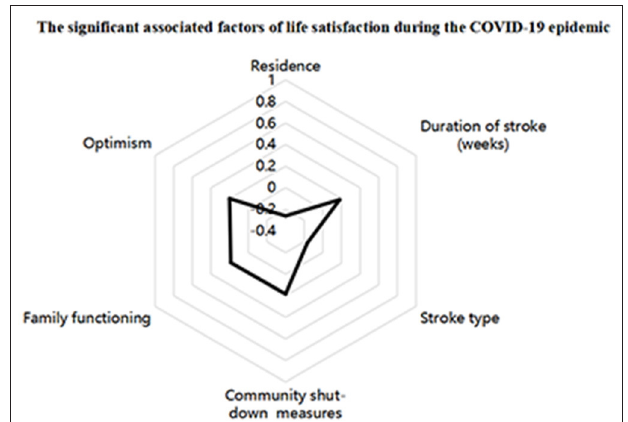
FIGURE 1 | The radar chart of life satisfaction. Residence (Rural areas); Duration of stroke ( > 2 weeks); Stroke type (Ischemic stroke); Community shut-down measures (No).